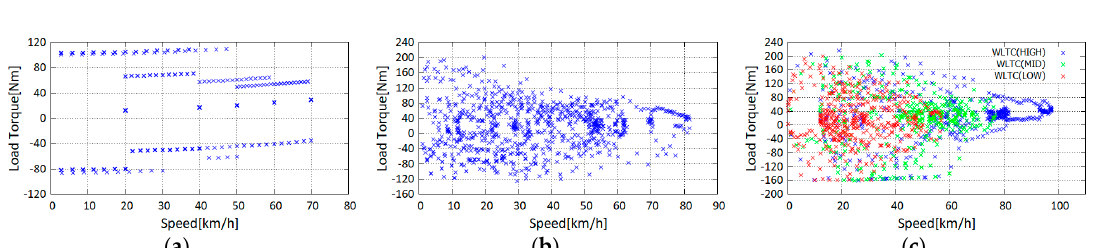
Figure 6. Driving pattern of JC08 mode.